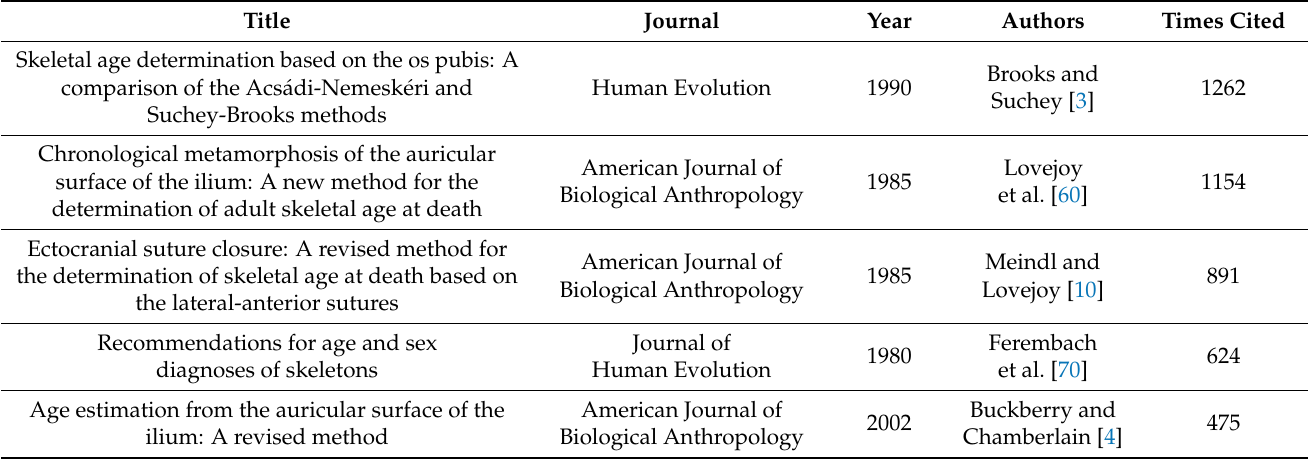
Table 1. TOP5 Titles most cited.